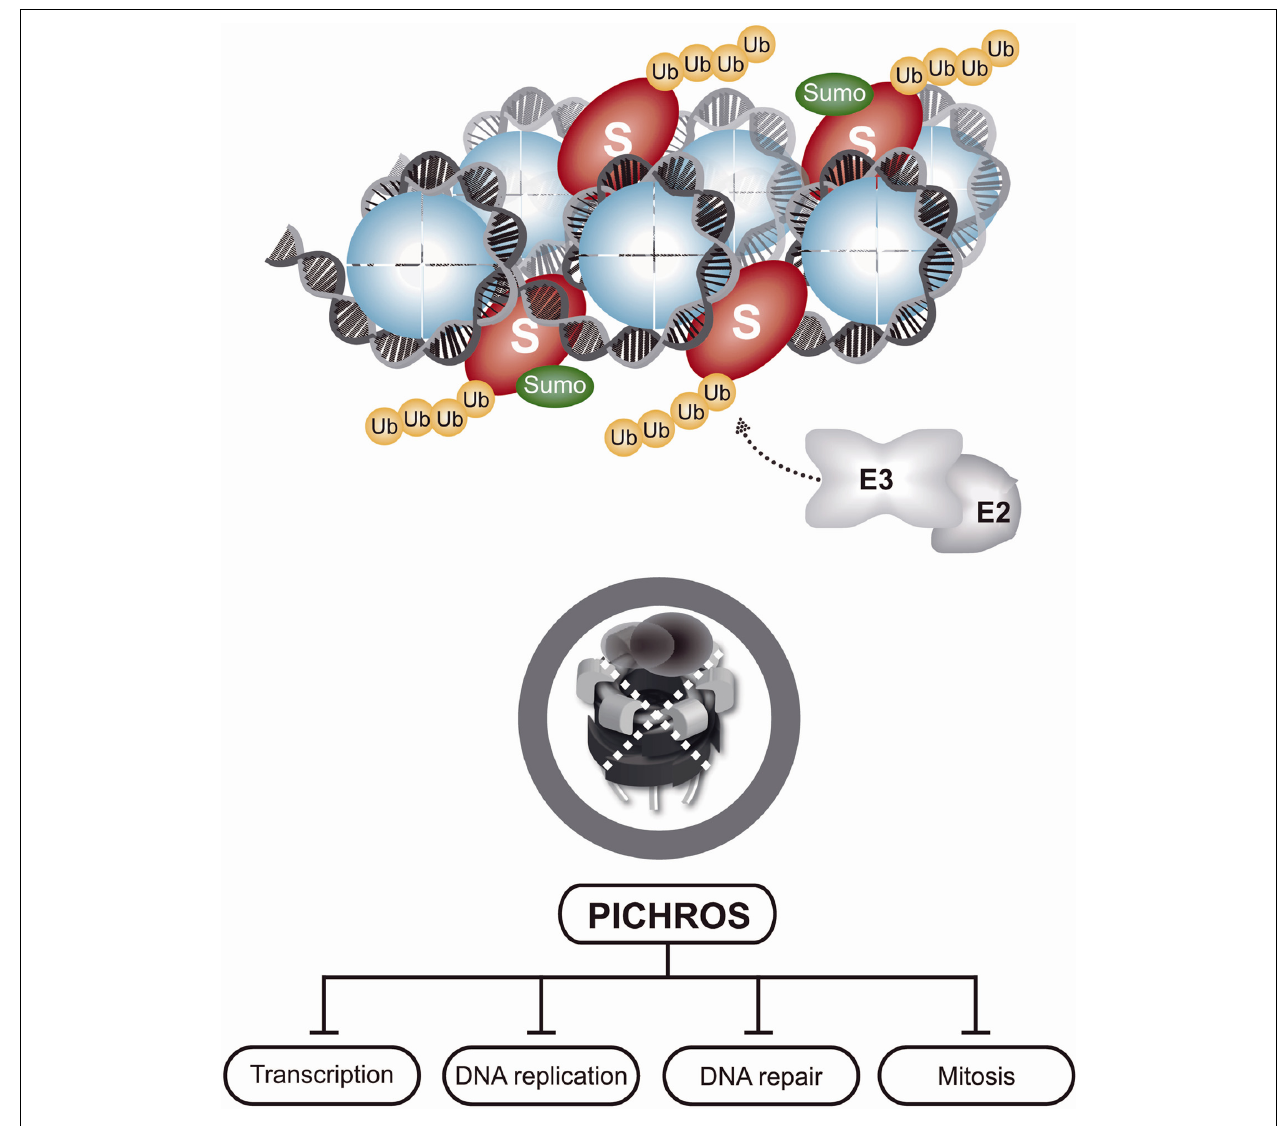
FIGURE 3 | Protein-induced chromatin stress (PICHROS). As indicated in Figure 2 , chromatin-bound substrates are polyubiquitinated, but cannot be removed due to inactivation of p97. Accumulation of polyubiquitinated